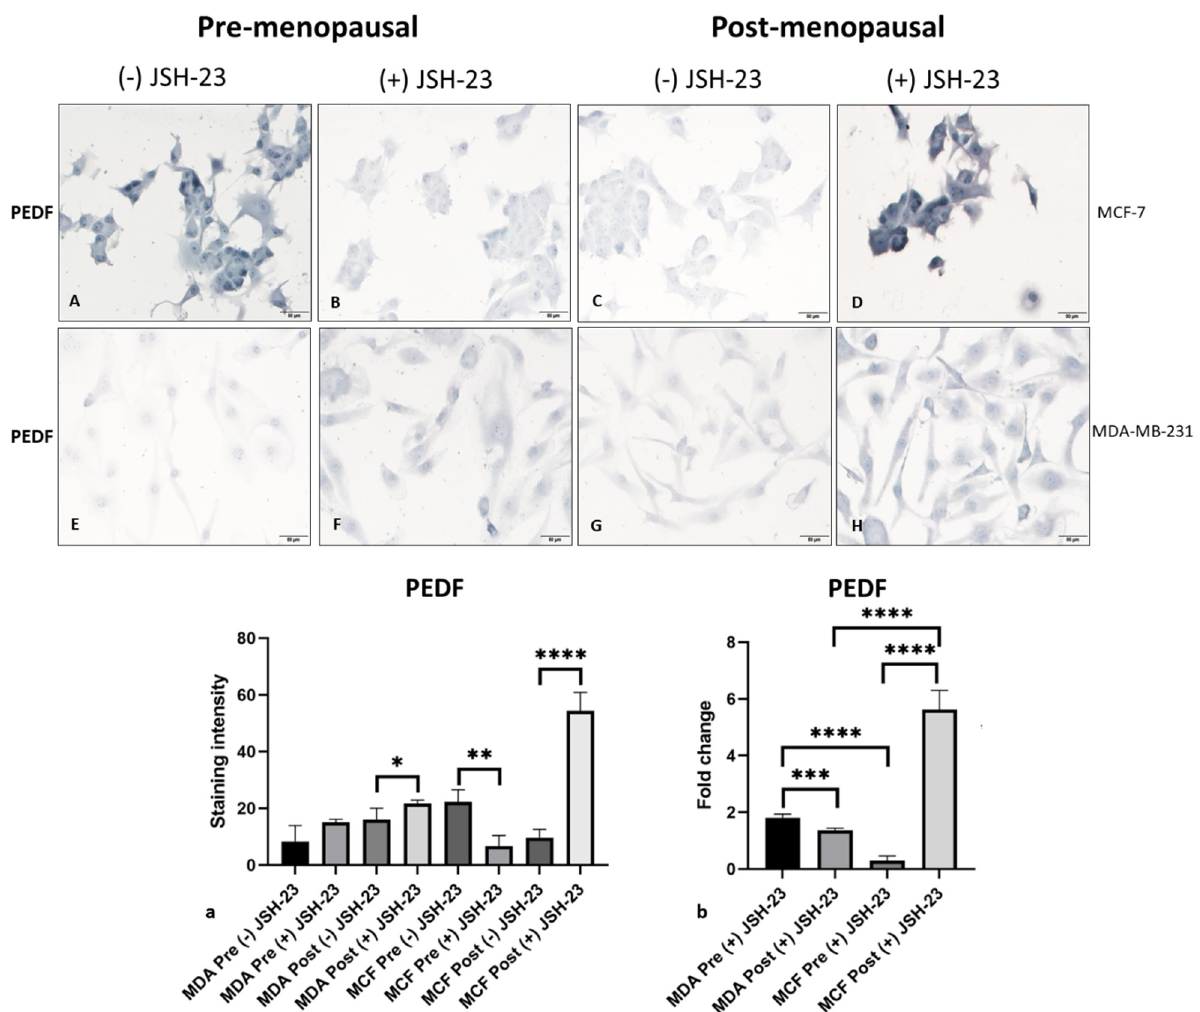
Figure 2. PEDF expression in MCF-7 and MDA-MB-231 cells following JSH-23 treatment in pre- versus post-menopausal oestrogens. PEDF expression determined via immunocytochemistry staining (blue) in cells following incubation in media supplemented with either pre-menopausal (E1: 258 pM; E1S: 4130 pM; E2: 271 pM) or post-menopausal (E1: 72 pM; E1S: 541 pM; E2: 14.6 pM) levels of oestrogens and treated with NF κ B-p65 inhibitor JSH-23 (20 µM) or control for 24-h. PEDF staining under pre-menopausal conditions in MCF-7 treated with control ( A ) or JSH-23 ( B ) and in MDA-MB-231 treated with control ( E ) or JSH-23 ( F ), and under post-menopausal conditions in MCF-7 treated with control ( C ) or JSH-23 ( D ) and in MDA-MB-231 treated with control ( G ) or JSH- 23 ( H ). PEDF staining intensity (total intensity (gray) of cells/total pixels of cells) in cells treated with control versus JSH-23 ( a ). PEDF expression fold change in JSH-23-treated cells compared to control in pre- or post-menopausal conditions for ( b ). Scale bar 50 µM. **** p < 0.0001; *** p = 0.0001–0.0009; ** p = 0.001-–0.009; * p = 0.01-–-0.05. As PEDF appears to be downregulated in post-menopausal ER+/HER2- BC bone me- tastasis [19] and NF κ B-p65 regulation of PEDF in BC cells depends on menopausal oes- trogen levels, we investigated the effects of PEDF and/or JSH-23 treatment on pro-meta- static biomarker expression under pre- and post-menopausal oestrogen conditions in MCF-7 and MDA-MB-231 cells (Figure 3). PEDF, JSH-23, and combined PEDF/JSH-23